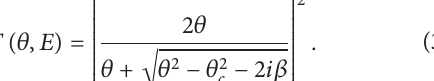
Figure 2: Schematic diagram of the radiation transport through the conical